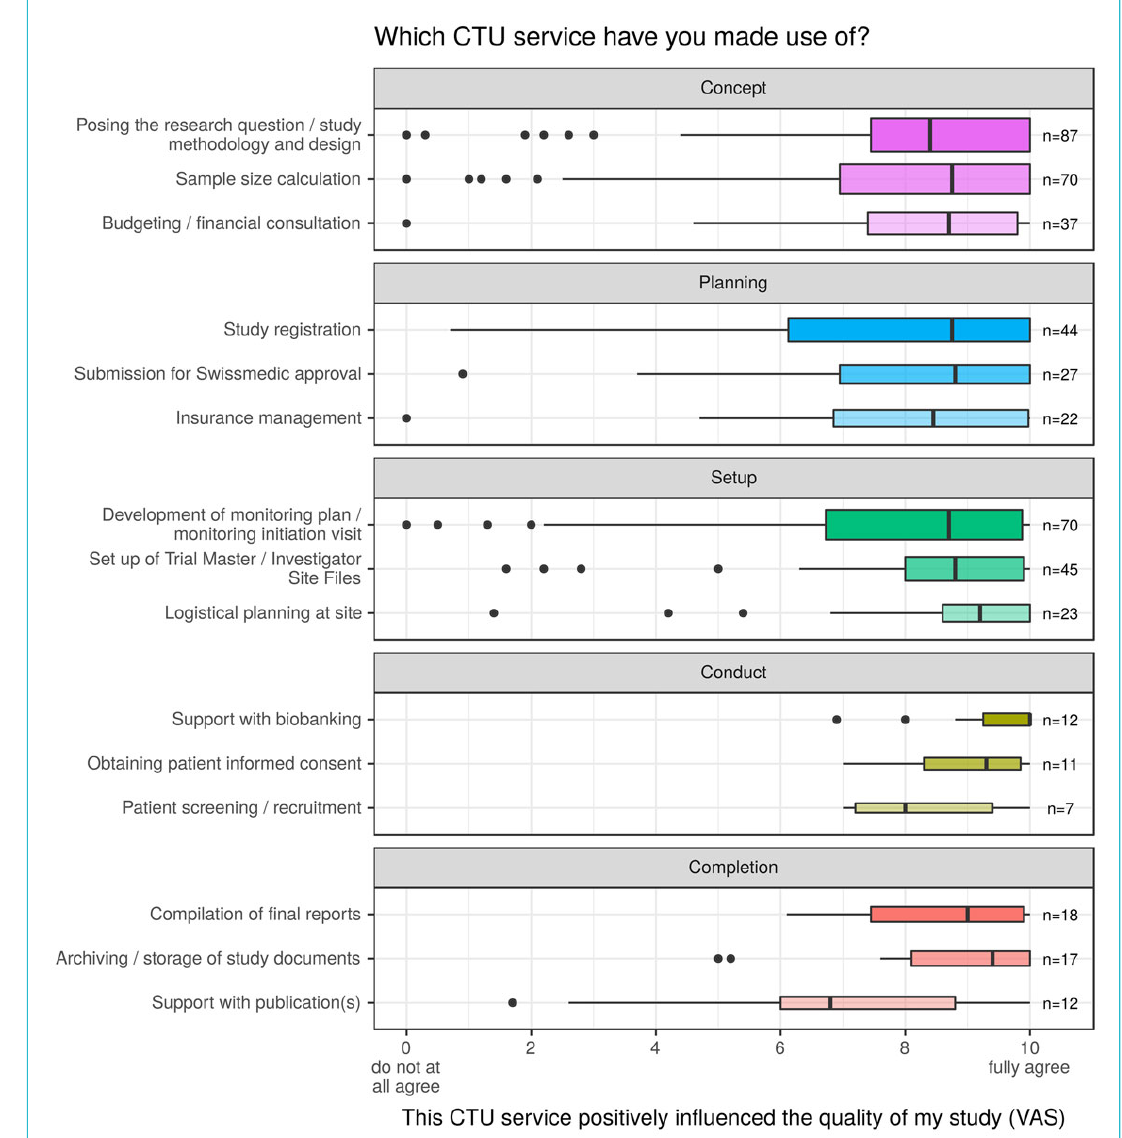
Figure 3: CTU customer survey responses regarding the impact of CTUs on the quality of the study performed (n = 155), by research stage.The box spans the interquartile range of answers between 0 and 10; the thick vertical line represents the median. Whiskers indicate the most extreme values lying within the box edge and 1.5 times the interquartile